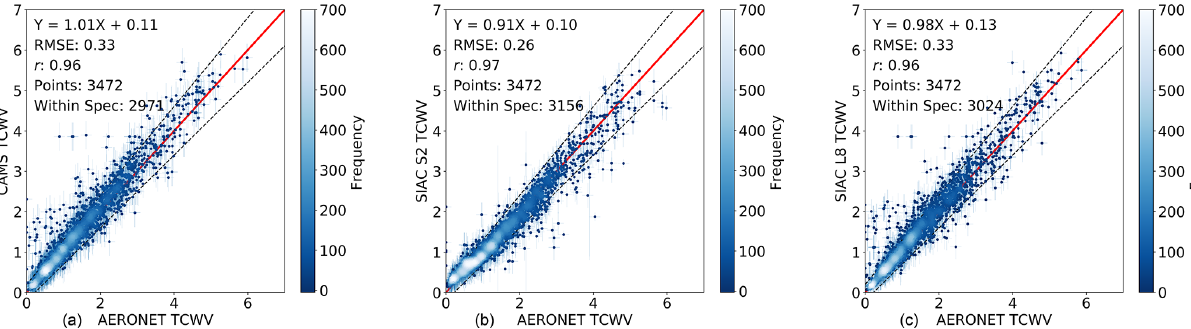
Figure 6. TCWV (gcm − 2 ) validation against AERONET measurements from CAMS (a) , SIAC S2 (b) , and SIAC L8 (c) over 3466 matches, where the vertical lines of each point are the uncertainty of solved TCWV values, and the horizontal error bars are 15% of AERONET TCWV values. Threshold uncertainty is shown as dashed lines in the figure.